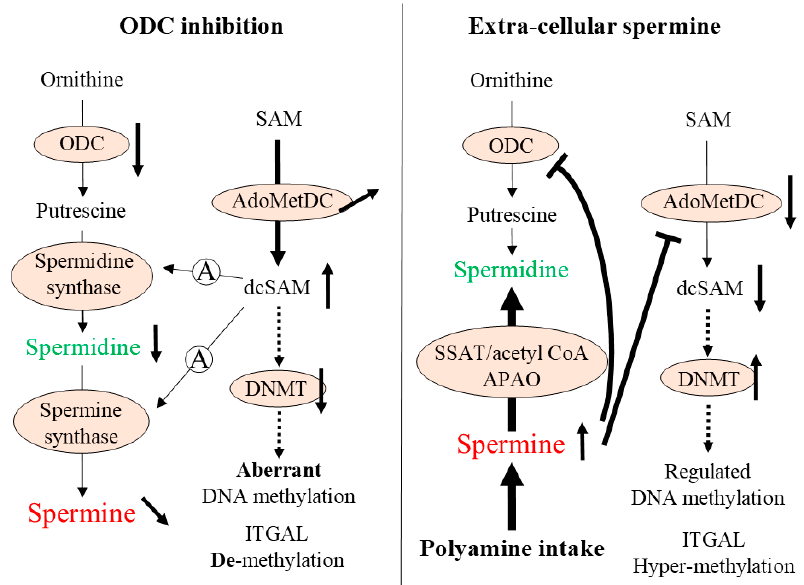
Figure 6. Summary of the study. (Left) When ODC is suppressed, AdoMetDC activity is either activated or unchanged. Decreased ODC results in decreased supply of putrescine for polyamine synthesis. The decreased supply of putrescine does not require an aminopropyl group (A in circle) from dcSAM. Therefore, surplus dcSAM inhibits DNMT 1, 3a, and 3b activities, resulting in aberrant methylation of the entire genome and demethylation of ITGAL. (Right) When spermine is supplied from extracellular sources as a result of increased polyamine intake, intracellular polyamine synthesis is suppressed. Spermidine is produced by the degradation of spermine via SSAT/Acetyl CoA and APAO, and therefore, no aminopropyl group (A in circle) is required for polyamine synthesis. This may result in strong inhibition of AdoMetDC (indicated by thick T-bar), resulting in a decrease of dcSAM concentration or dcSAM/SAM ratio. Decreased dcSAM re-activates DNMT 3a and 3b, resulting in regulation of the methylation status of the entire genome as well as hypermethylation of ITGAL. Hypermethylation of ITGAL suppresses aging-associated enhancement of the pro-inflammatory status by decreasing protein levels of LFA-1. Inhibition of aberrant DNA methylation may result in inhibition of various aging-associated pathological changes. Arrows indicate the metabolic pathway or flow of substances. T-bars indicate inhibitory activity. Dashed arrows indicate the consequence (downstream) induced by the change (upstream). ODC: Ornithine decarboxylase, SAM: S-adenosylmethionine,